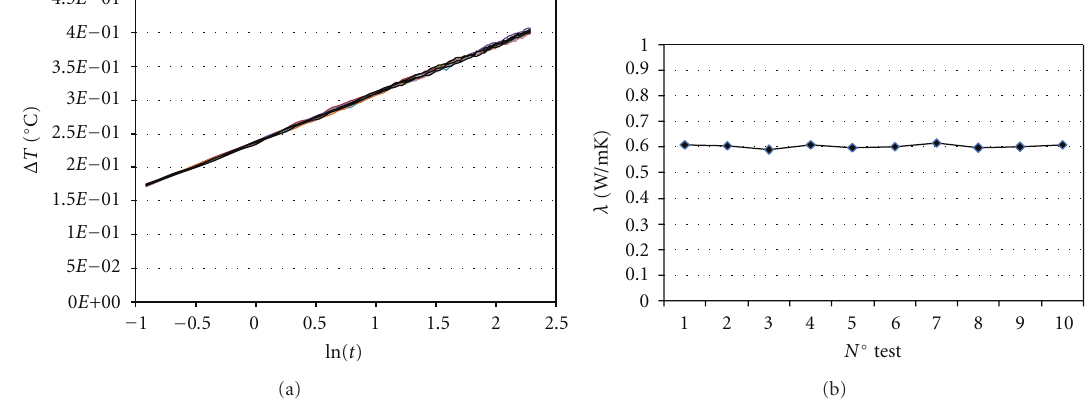
Figure 2: (a) Superimposition of the Δ T/ ln( t ) curves for 10 successive measurements in water (22 ◦ C). (b) Evolution of the water λ measured: λ = 0 . 602 W/mK with 0.008 W/mK standard deviation. water